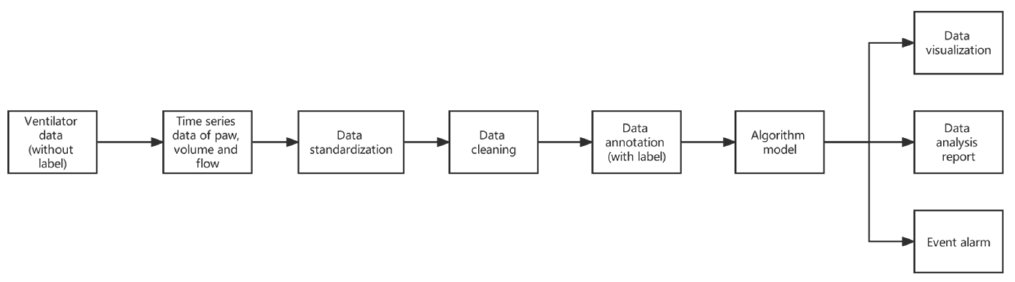
Figure 3. Flow chart of mechanical ventilation event alarm.